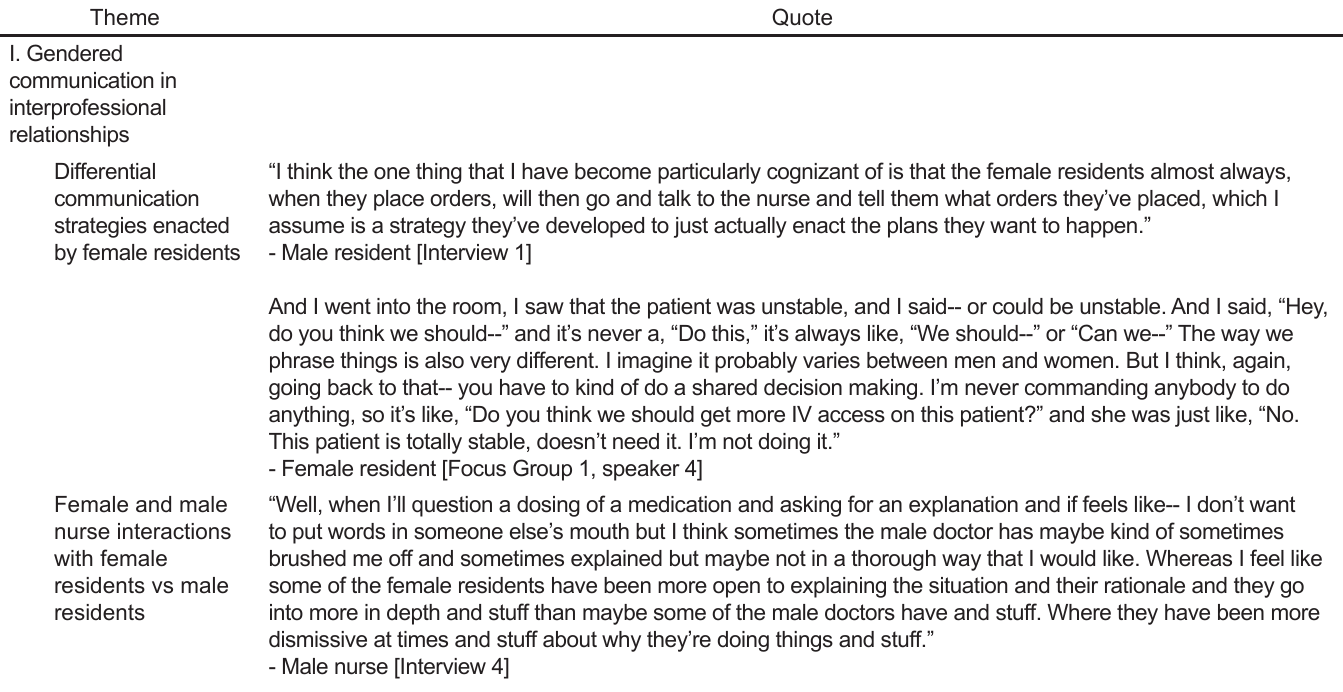
Table 2. Representative